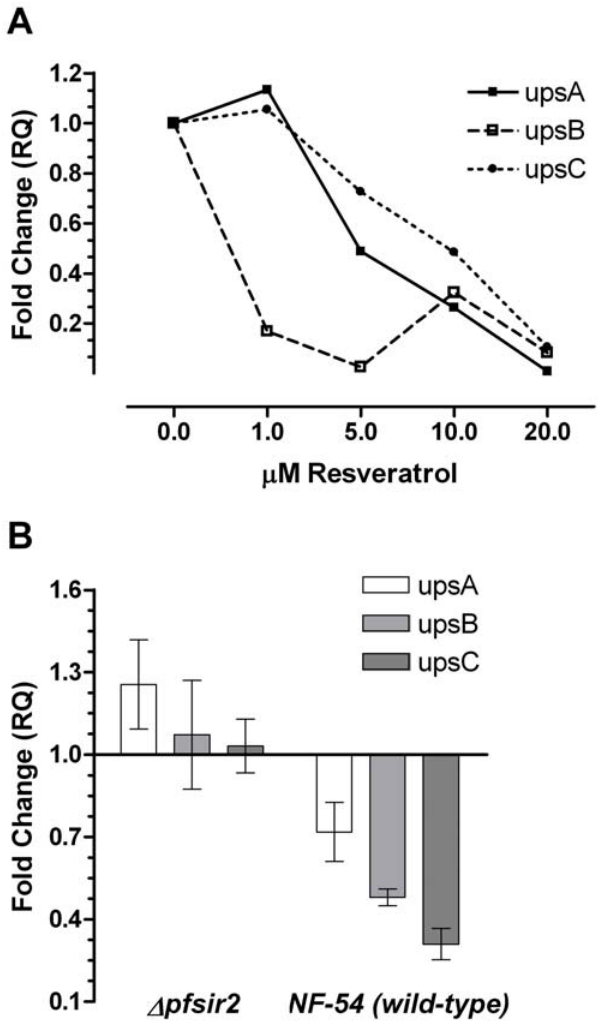
Figure 5. The effect of resveratrol on var gene expression. A. Analysis of expression of var subtypes upon exposure to RV in wild-type parasites. Synchronized ring stage parasites were exposed for 8 hours to various concentrations of RV. B. Analysis of expression of var subtypes upon exposure to 10 m M RV in wild-type and D pfsir2 parasites. Synchronized ring stage parasites were exposed for 8 hours to 10 m M RV. cDNA production and qPCR analysis were performed as described in the legend to Fig. 1.